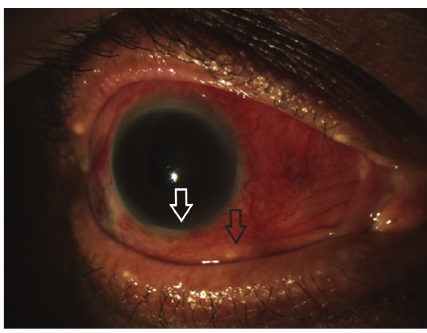
Figure 1: Anterior segment photograph of the right eye showing an inferonasal conjunctival abscess (black arrow) and hypopyon (white arrow) with marked conjunctival injection and chemosis.